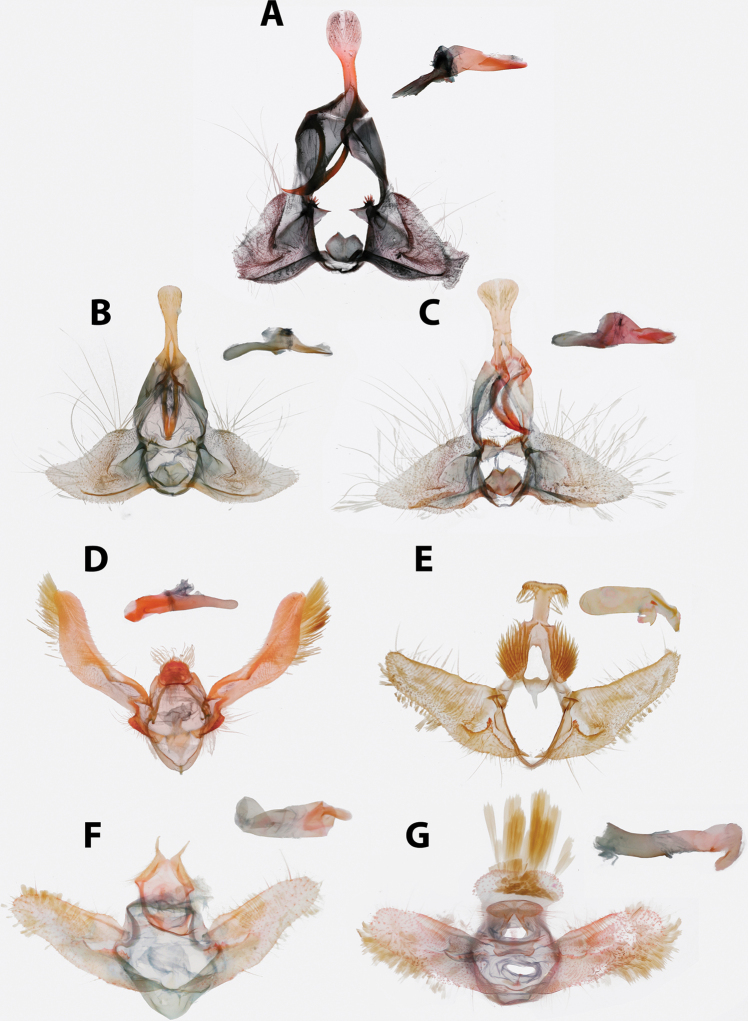
Clepsis and Mictopsichia group of genera male genitalia. Phallus inset. Not to scale. ACle.
deroni sp. nov. paratype, Dominican Republic. KAA diss. #0057 (CMNH) BCle.
jamesstewarti sp. nov. paratype, Dominican Republic. KAA diss. #0143 (CMNH) CCle.
davisi sp. nov. paratype, Guadeloupe. KAA diss. #0184 (CUIC) DRubropsichia
santaremana, Grenada. KAA diss. #0133 (BMNH) EMictocommosis
lesleyae sp. nov. holotype, Dominican Republic. KAA diss. #0173 (CMNH) FMictopsichia
cubae, Dominican Republic. KAA diss. #0130 (CMNH) GMictopsichia
nyhllinda sp. nov. holotype, Dominican Republic. KAA diss. #0200; scaled tergite VIII left intact (CMNH).